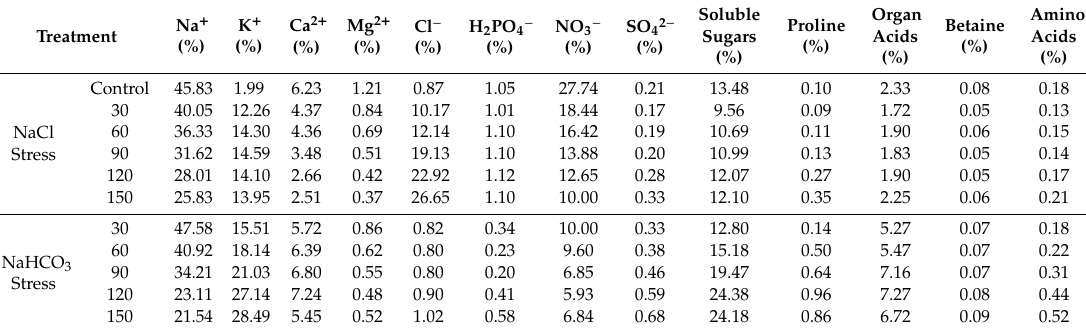
Table 3. Contribution of each solute molarity to the total determined osmoregulators molarity in common bean roots under neutral salt and alkaline salt stresses. Percentages were calculated from the mean values of each